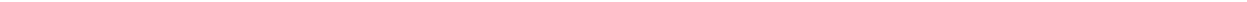
Fig. 4 Spatial distribution of detected ions with sub-regions of a mouse hippocampal tissue by MS imaging. Two optical images indicated three analysis regions of CA1, CA3, and DG; a before the MS analysis and b after MS analysis. Scale bars, 500 μ m. c , d identi fi ed ion images were compared with CA1, CA3, and DG. Ion images were generated with 433 × 100 pixels covering an area of 600 × 500 µ m, and the corresponding x -axial and y -axial pixel sizes were 1.4 and 5 µ m, respectively. According to experiment, the ion images had x -axial and y -axial lateral resolutions of 2.9 and 5 µ m, respectively (Fig. 5). e Six identical ROIs were assigned to each side based on adenine boundary of CA3 using the function of ROI analysis in BioMap software. The three left areas indicate the apical dendrite areas and the three right areas indicate the basal dendrite areas. f Relative proportions of detected ions, where the intensities of apical dendritic populated areas were normalized to 100% (raw data is shown in Supplementary Table 1). Shown are means ± SDs from nine independent ions in each of the three regions. Asterisks indicated P values. ** P < 0.01; *** P < 0.001. g Distribution of ion intensities of MAG (18:1) in c , and adenine in d , along x -axial position. The values of graph represented averages of forty y -axial values per each x -position (middle 40 lines of 100 lines in y -direction) and also averages per 10 µ m along the x -direction, from 0 to 600 µ